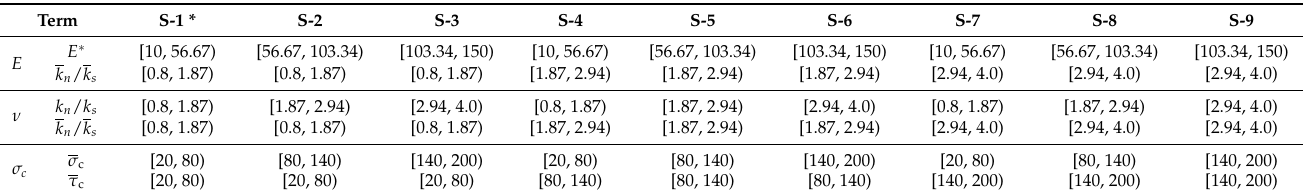
Table 4. Division of subintervals for response